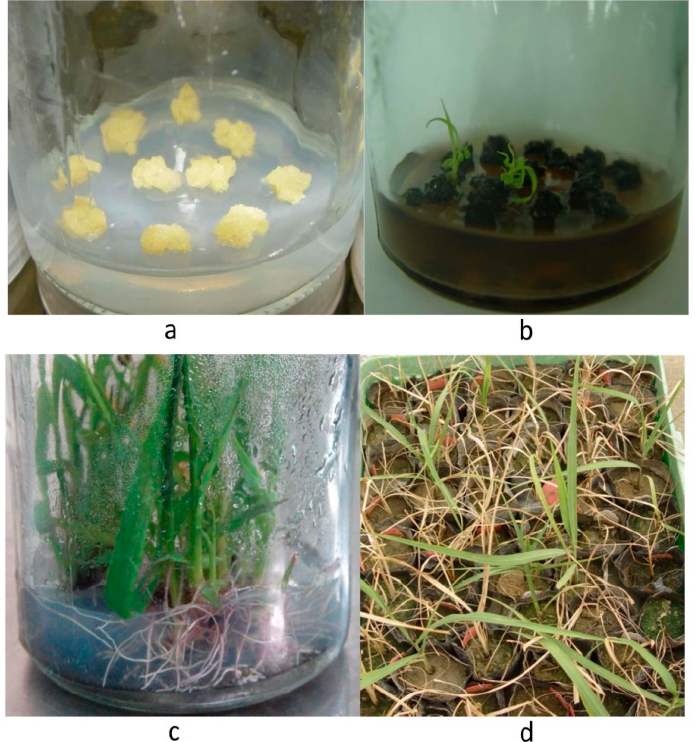
Figure 3. Putative recombinant screening: ( a ) wild-type calli on medium without PPT; ( b ) PPT-resistant plantlets at the differentiation stage on selection medium; ( c ) regenerated plantlets at the stage of rooting culture; and ( d ) spraying screening of resistant plantlets with 3.0‰ Basta.